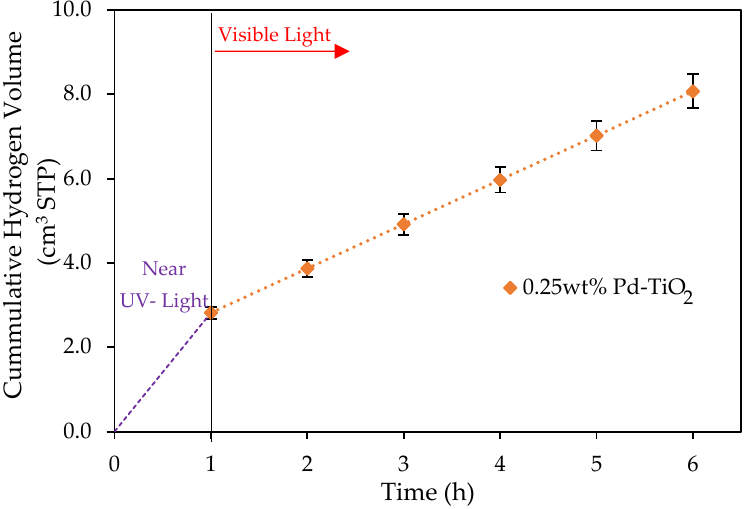
0.02.04.06.08.010.0